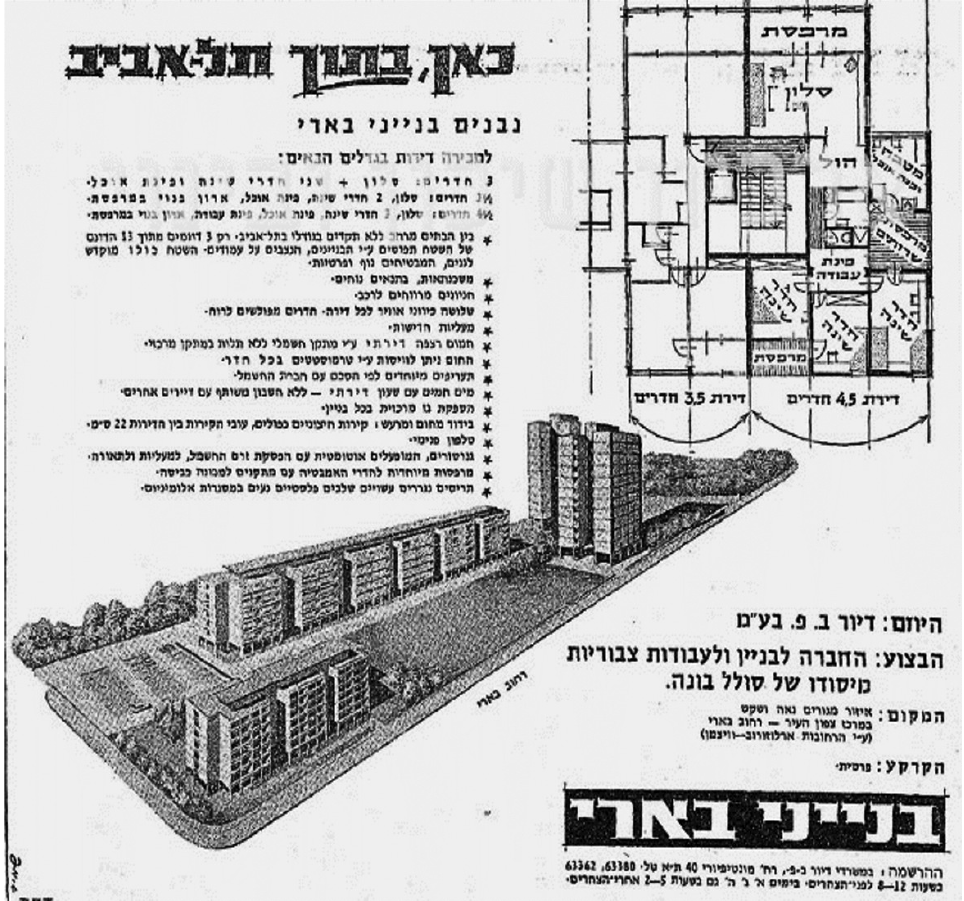
Figure 12. Be’eri estate advertisement. Source: “Binyanei Be’eri”